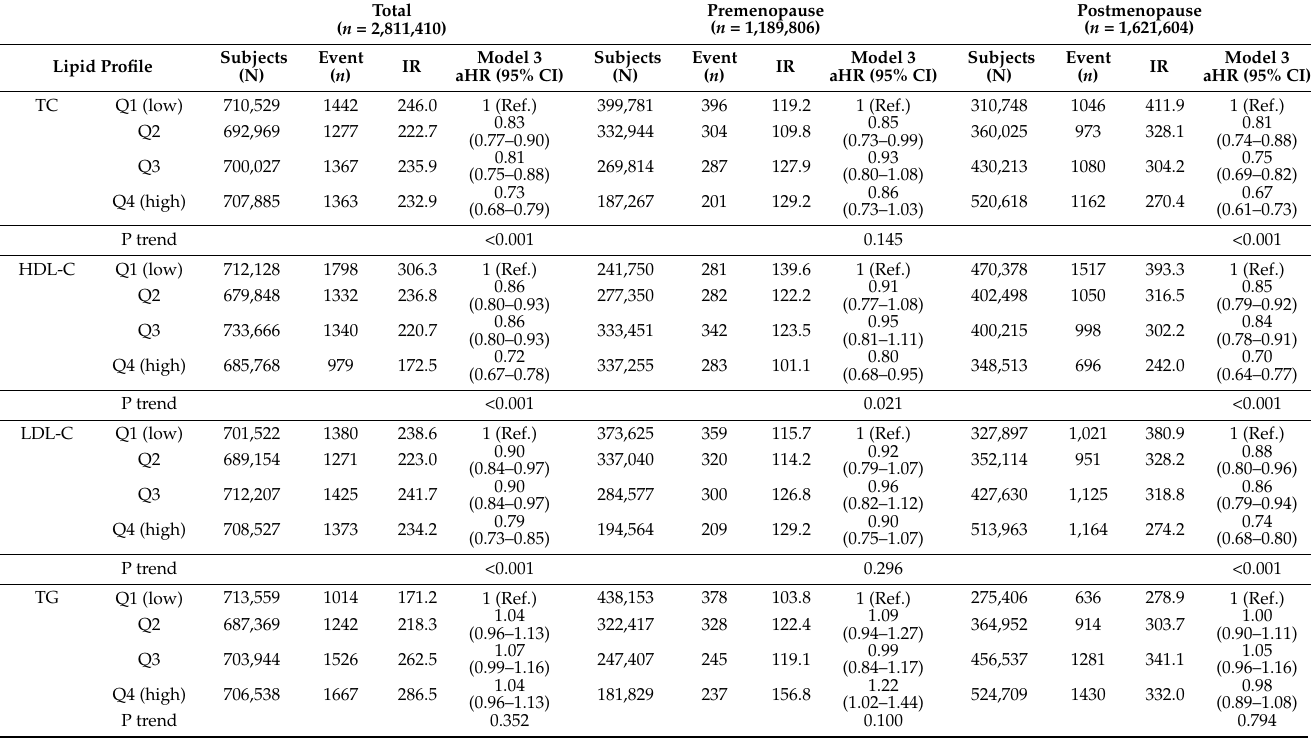
Table 2. Risk of hematologic malignancy by quartile of each lipid profile according to menopausal